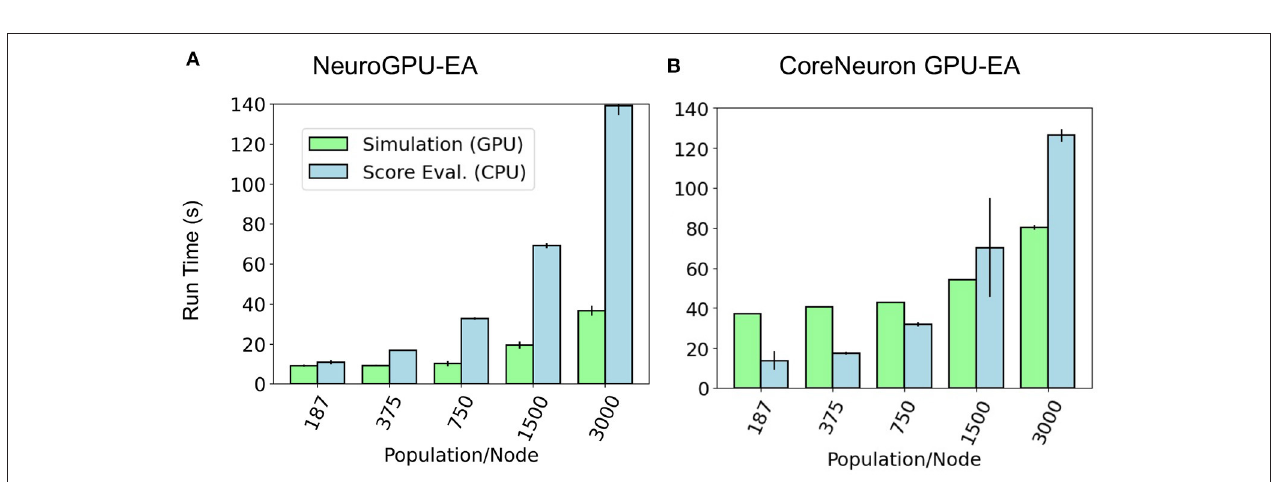
FIGURE 3 | Simulation-evaluation scaling CPU vs. GPU: Experiments measuring the time it takes to run one simulation-evaluation step using NeuroGPU-EA , CoreNeuron-EA , and CPU-EA . (A) One compute node and population size increases, as in Table 1 . (B) Increases compute nodes and population size is constant, as in Table 2 . (C) Increasing compute nodes and population size, as in Table 3 .